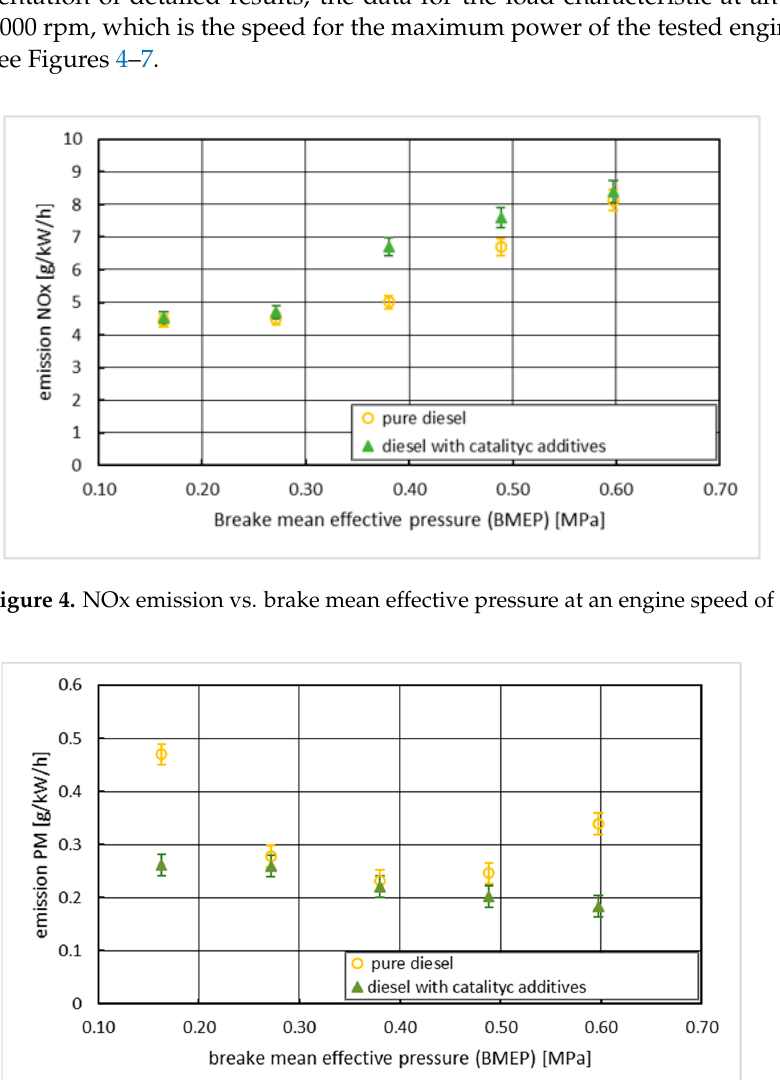
Figure 5. PM emission vs. brake mean effective pressure at an engine speed of 2000 rpm.